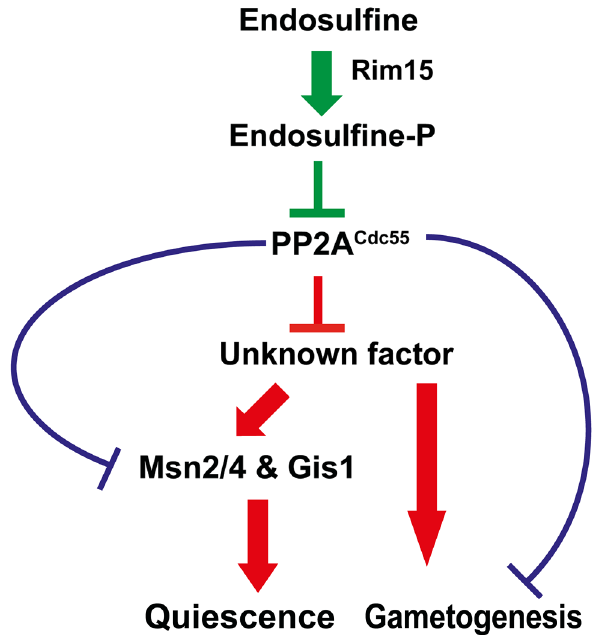
Figure 8. Regulation of entry into gametogenesis and quies- cence by the Rim15-Endosulfine-PP2A Cdc55 signalling module. Phosphorylation of endosulfine by Rim15 converts it into an inhibitor of PP2A Cdc55 and thus leading to entry into gametogenesis and quiescence. Entry into quiescence is driven by activation of transcrip- tion factors Msn2, Msn4 and Gis1. PP2A Cdc55 might inhibit a positive regulator of entry into gametogenesis and quiescence. Alternatively, PP2A Cdc55 could inhibit entry into quiescence and gametogenesis by dephosphorylating distinct substrates.